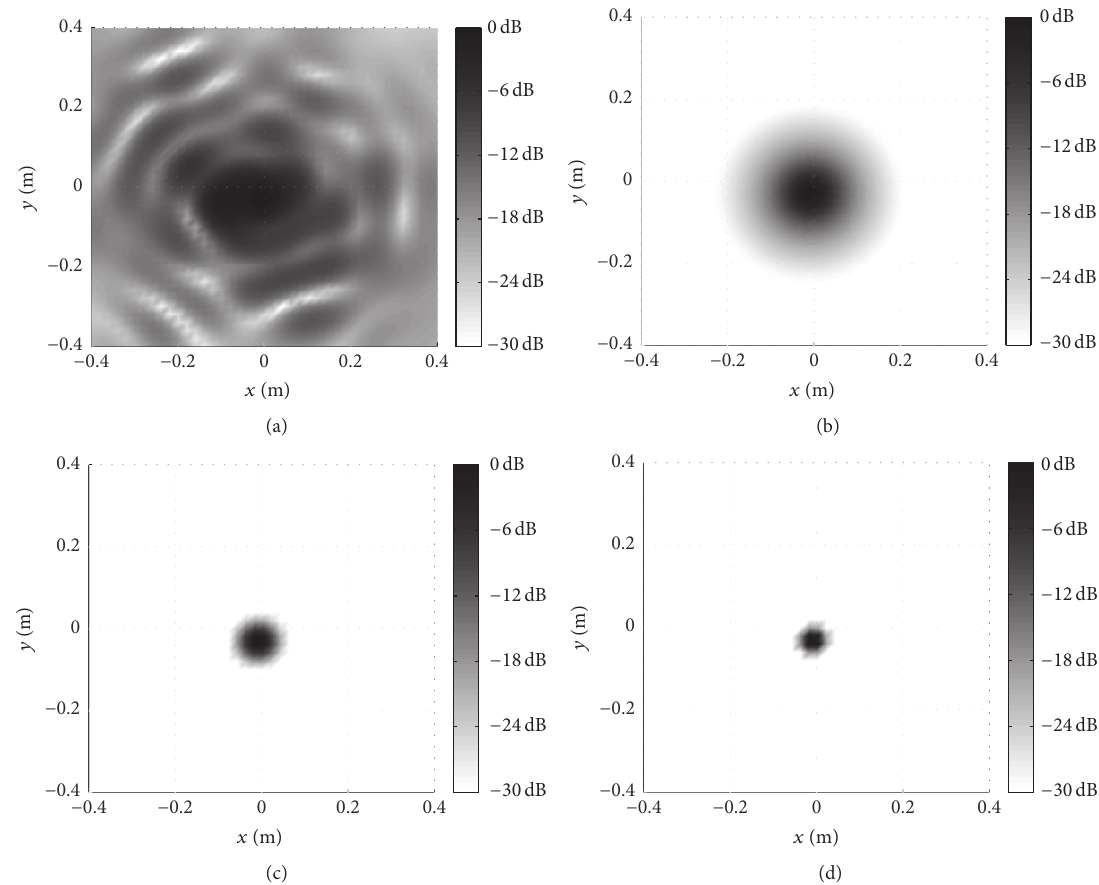
Figure 10: Noise source map for single source (1800Hz). (a) WBH. (b) iWBH. (c) IFESM, V = 2 . (d) IFESM, V = 6 .